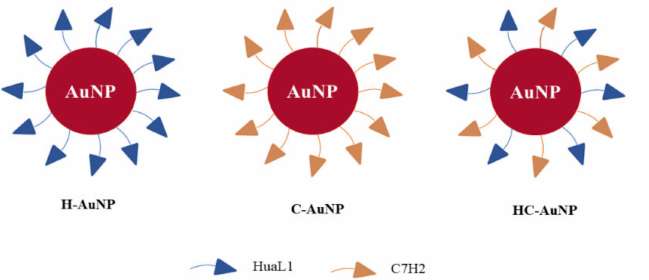
Figure 1. Schematic representation of peptides-conjugated AuNPs obtained after the NPs’ functional- ization with the peptides C7H2 and HuaL1 in isolation or